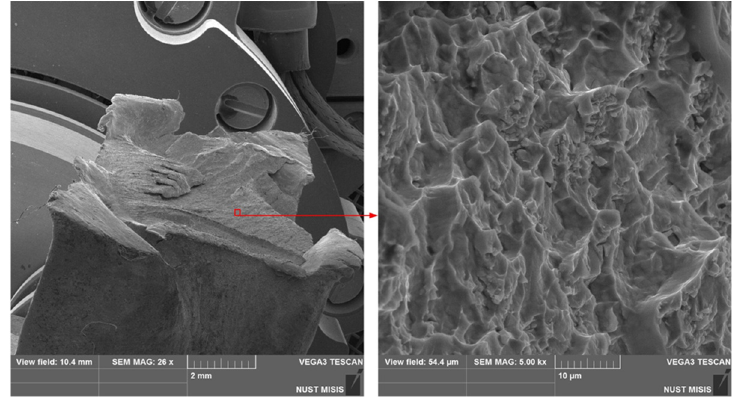
Figure 2. Scanning electron microscopy image of the NiTi SMA sample in the place of destruction after deformation at 330 °C with e = 9.5.